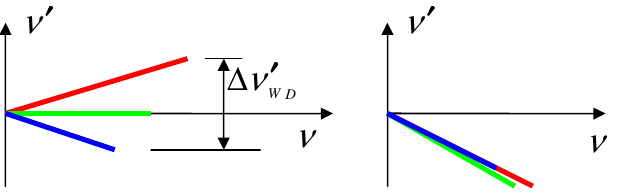
FIG. 11. (Color) The phase-spaces just before (left) and after (right) the linac’s entrance. The red, green, and blue lines represent the phase-spaces of the smaller energy, median energy, and higher energy slices, respectively.